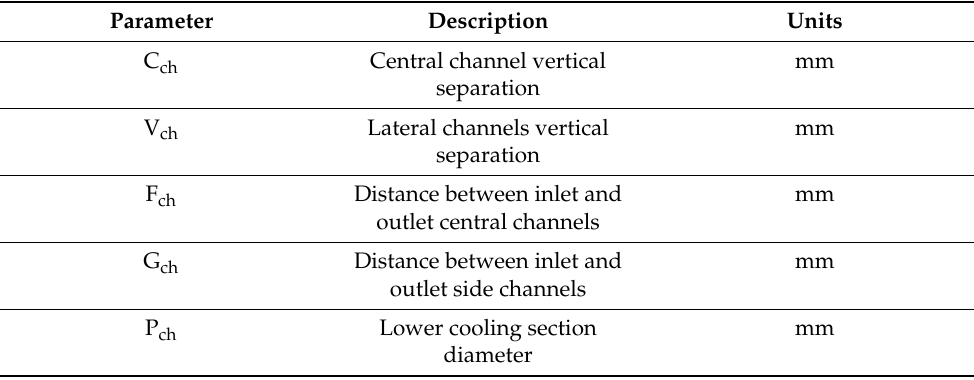
Figure 11. V ch parameter.